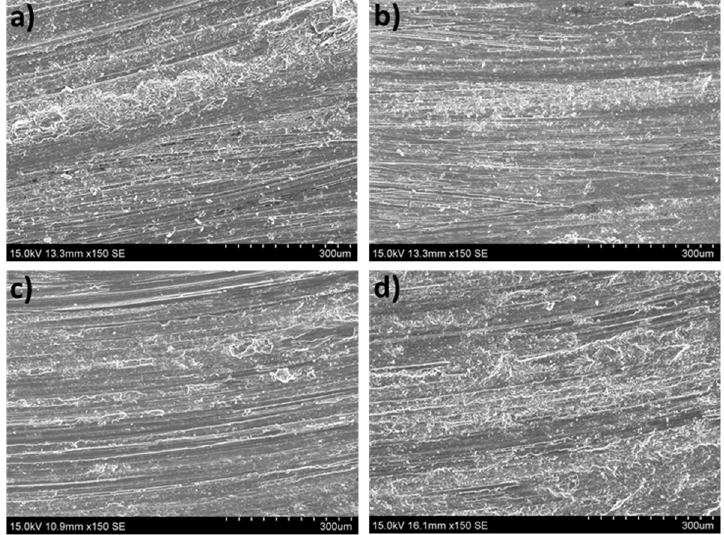
Figure 8. Worn tracks observed for the as-cast ZX30 alloy tested under the different wear conditions: ( a ) 2 N, 0.05 m s − 1 ; ( b ) 20 N, 0.05 m s − 1 ; ( c ) 2 N, 0.1 m s − 1 ; ( d ) 20 N, 0.1 m s − 1 .